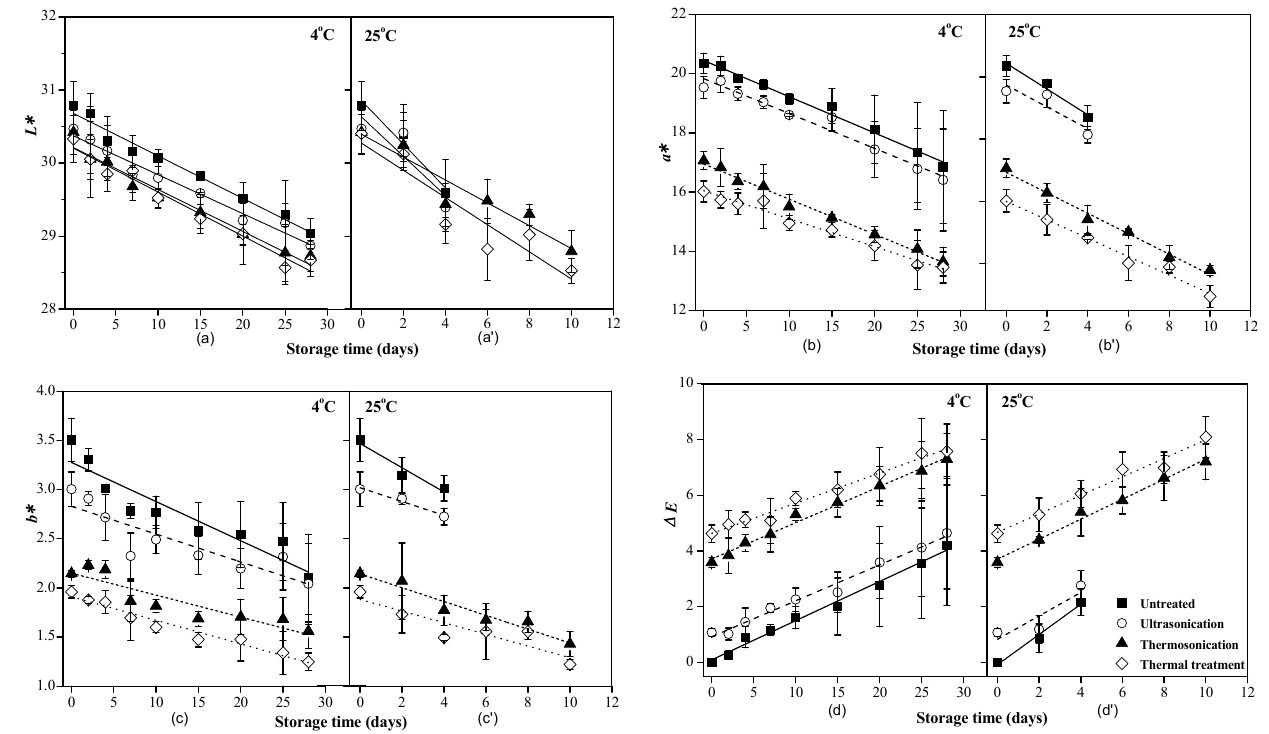
Figure 4. Variance in color of red pitaya juices during storage at 4 °C and 25 °C, as subjected to thermosonication (475 W, 56 °C, 20 min), ultrasonication (475 W, 10 °C, 20 min), and thermal (83 °C, 1.5 min) treatments. ( a , a’ ) Description of L * values during storage; ( b , b’ ) Description of a * values during storage; ( c , c’ ) Description of b * values during storage; ( d , d’ ) Description of ∆ E values during storage. Dotted lines are fitting curves with the linear